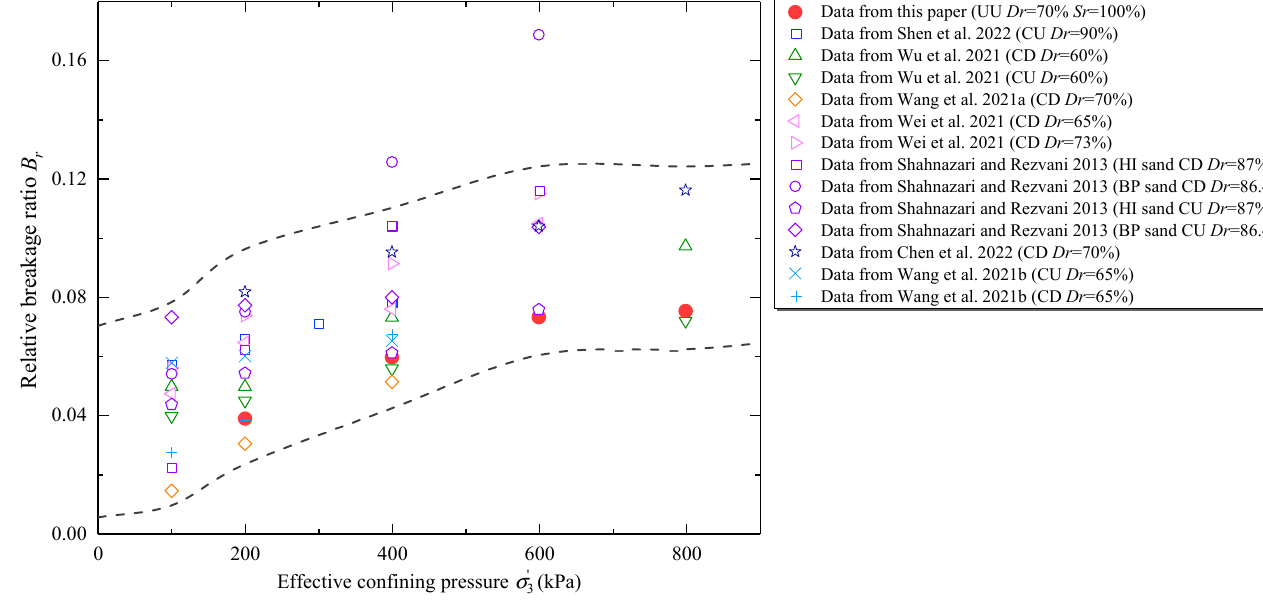
Figure 16. Previous test results of particle breakage of coral sand [25,27,28,33,39,60].